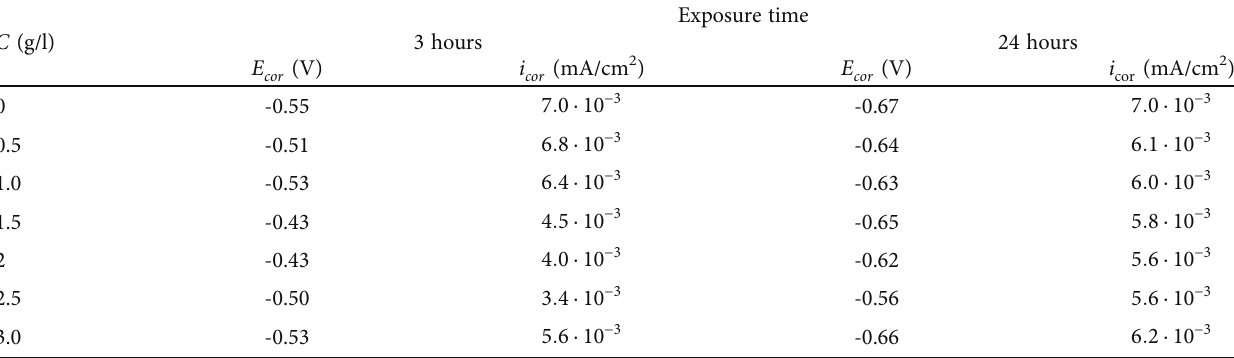
Figure 3: Polarization curves of 09G2S steel after 3 hours (a) and 24 hours (b) of exposure to a 0.1% NaCl solution with sodium citrate concentration of (1) 0 g/l, (2) 0.5 g/l, (3) 1.0g/l, (4) 1.5g/l, (5) 2.0g/l, (6) 2.5g/l, and (7) 3.0g/l. Table 2: Electrochemical characteristics of steel 09G2S after exposure to 0.1% NaCl solution with di ff erent concentrations of sodium